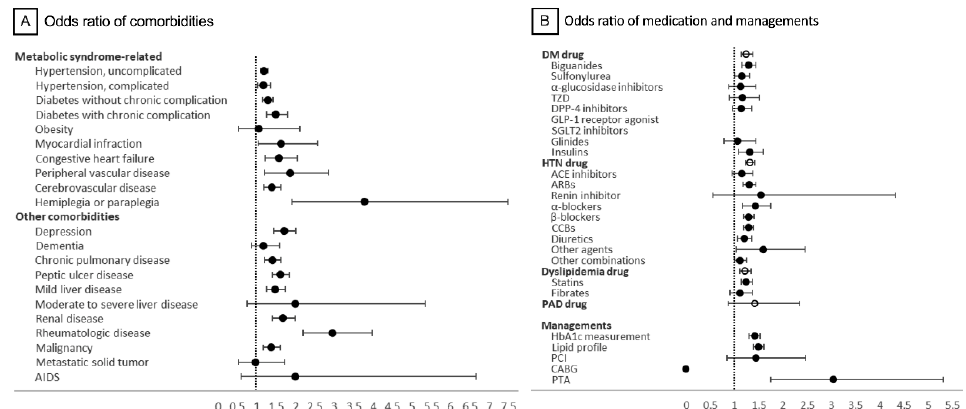
Figure 3. Odds ratio of comorbidities, medications, and managements. The odds ratios were calculated as the odds of IRD patients divided by the odds of control group. The odds were calculated as those with comorbidities in each group divided by those without comorbidities. ( A ) Odds ratios of the metabolic syndrome and other comorbidities were analyzed between the inherited retinal degeneration (IRD) and control groups. ( B ) Odds ratios of the common medications and procedures for metabolic syndrome were analyzed between the IRD and control groups. Abbreviations: AIDS, acquired immune deficiency syndrome; DM, diabetes mellitus; HTN, hypertension; PAD, peripheral artery disease; PCI, percutaneous coronary interventions; CABG, coronary bypass graft surgery; PTA, percutaneous transluminal angiography.